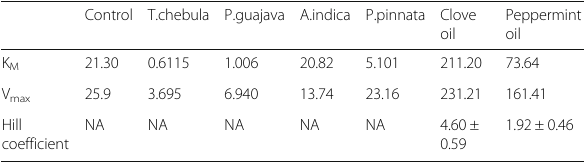
Table 4 Kinetic parameters of the inhibitory effect of test samples on the activity of